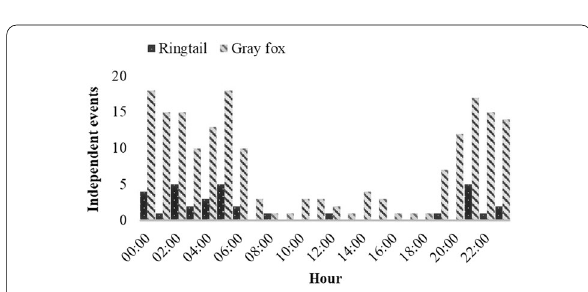
Fig. 6 Activity patterns of mammalian carnivores in riparian and non‑riparian zones